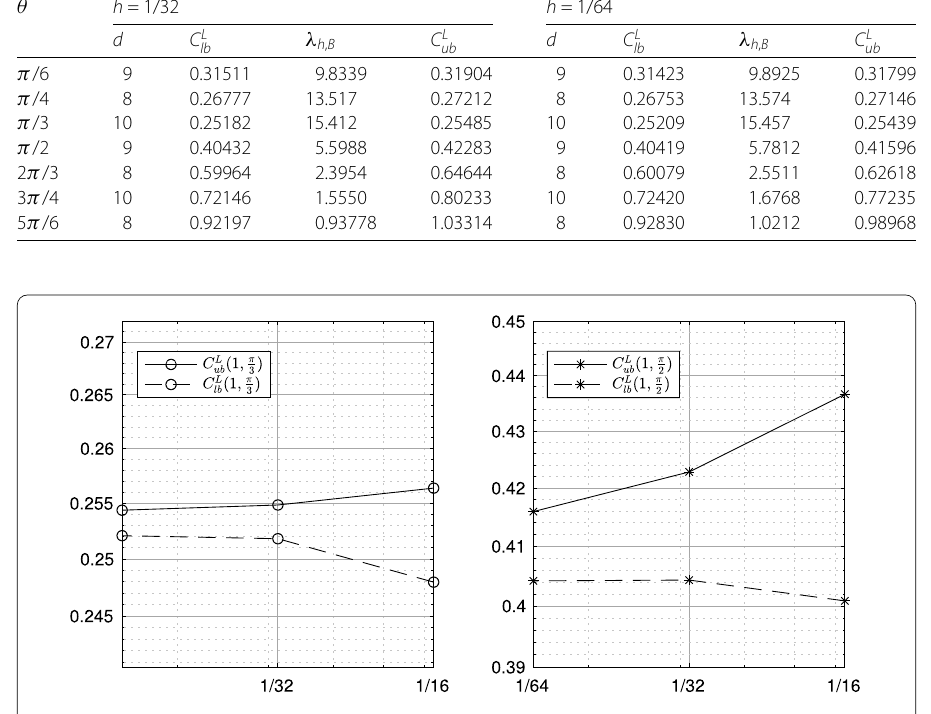
Figure 11 The convergency behavior of the upper and lower bounds of C L (1, θ ) for θ = π /3 and π